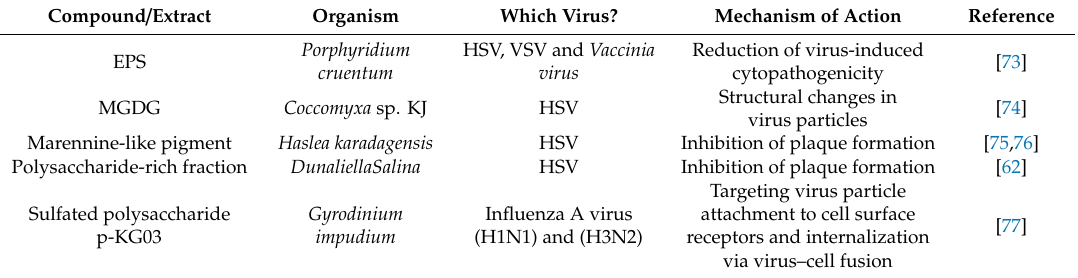
Table 3. Antiviral compounds from microalgae. HSV, Herpes Simplex virus; VSV, Vescicular